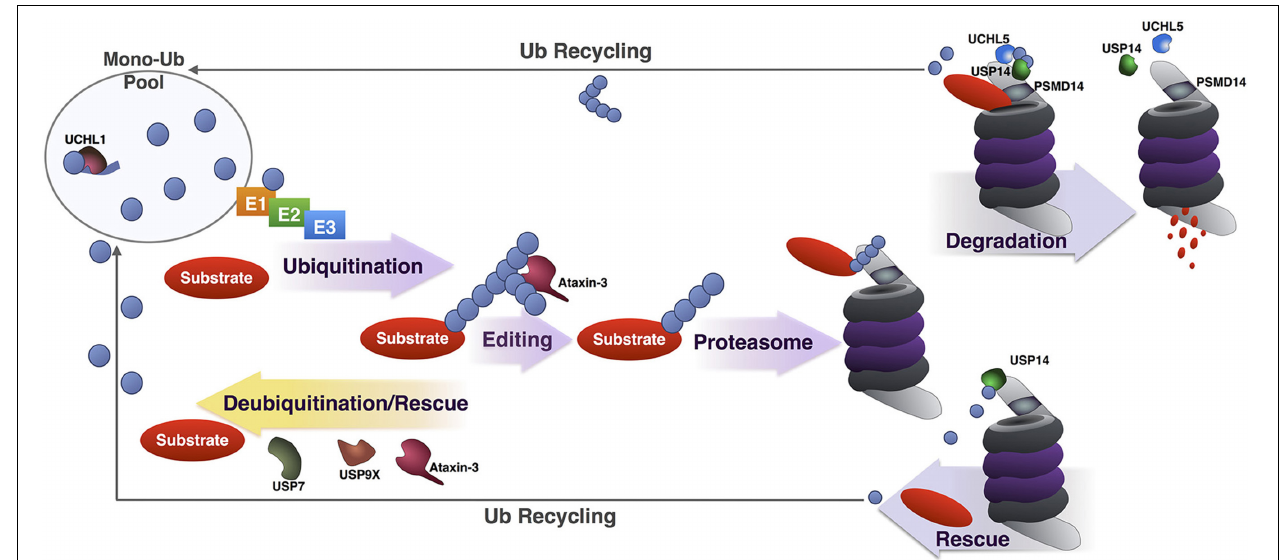
FIGURE 4 | Summary of DUBs involved in various steps of the UPP. Summary of the various steps of substrate ubiquitination and degradation during which specific DUBs involved in the UPP are reported to function. UCHL1 maintains a pool of mono-Ub for conjugation by removing additional amino acids present in newly translated Ub, or by processing accidental thiol or amine modifications formed during Ub reactions. Once a substrate has been ubiquitinated, DUBs such as USP7, USP9X and under some